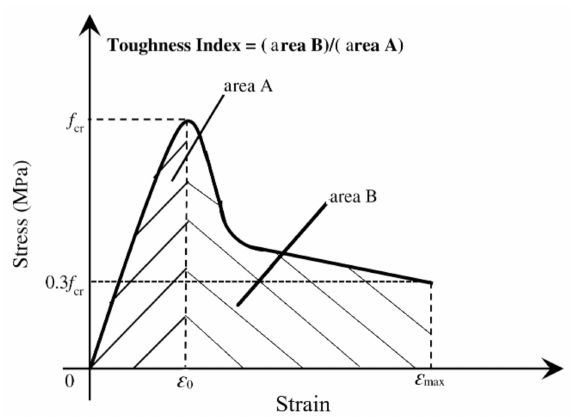
Figure 7. The calculation of uniaxial compression toughness